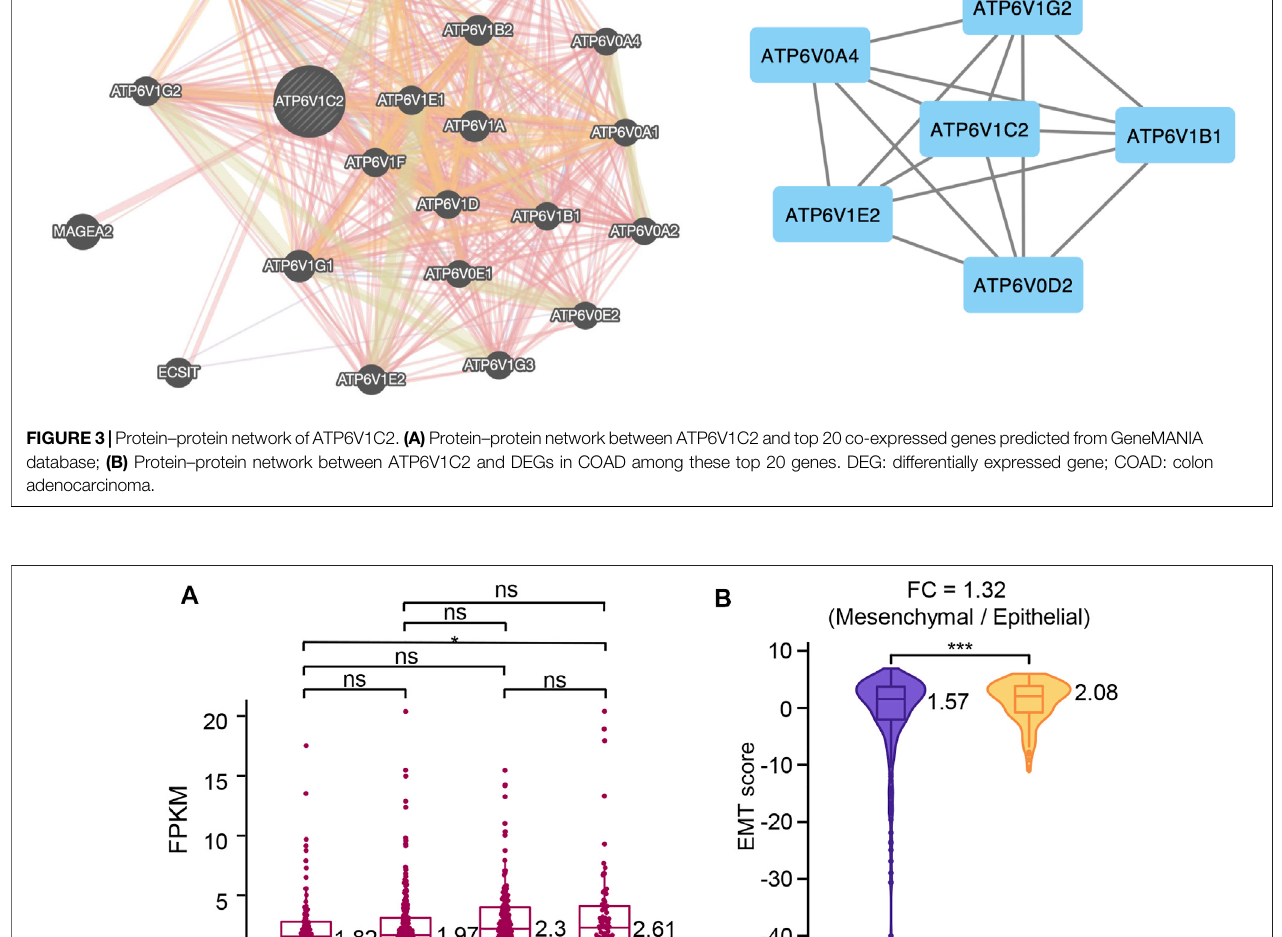
Frontiers in Genetics |